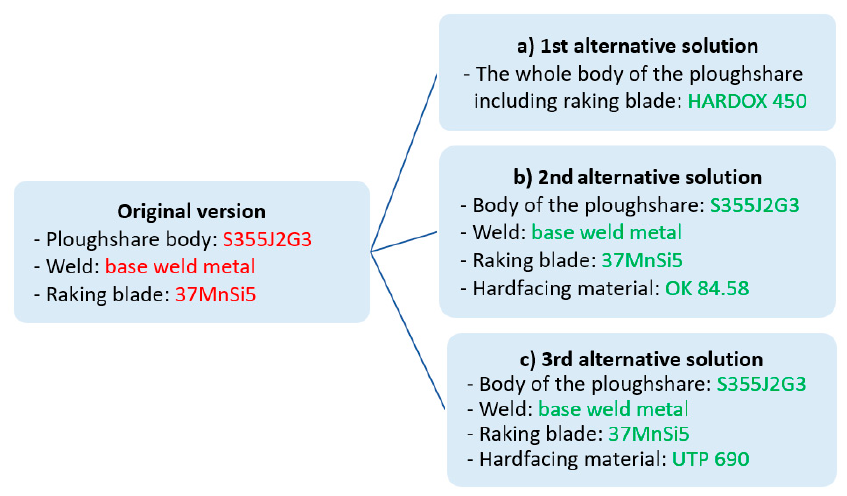
Figure 4. Suggested research solutions regarding the current